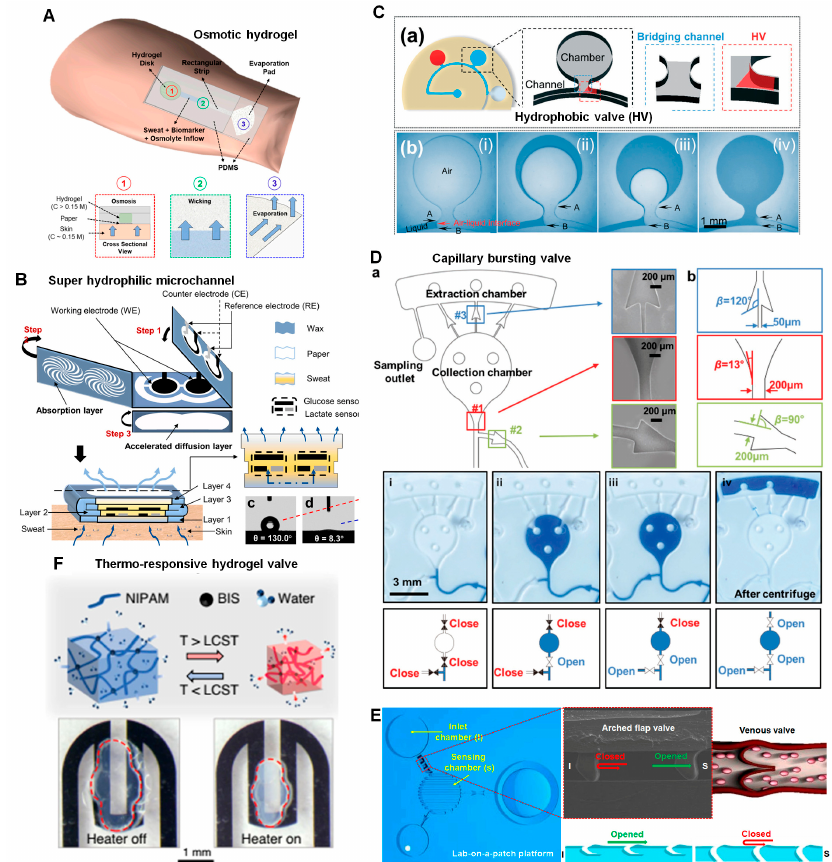
Figure 5. Epidermal wearable biosensors for active sweat collection. The structures of the micro- fluidic channels have been greatly improved for efficient and controllable sweat collection, such